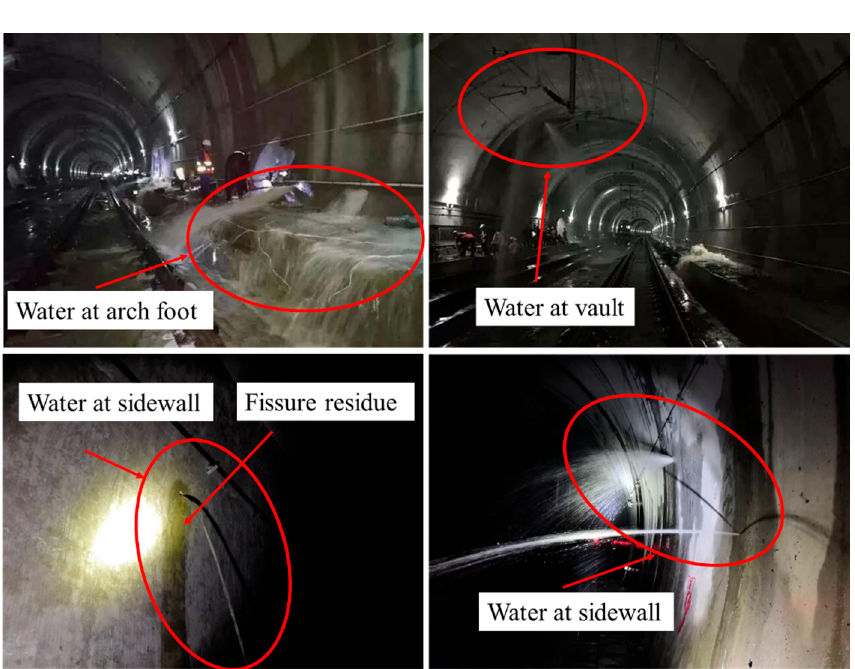
Figure 2. Water leakage in different position of tunnel structure.